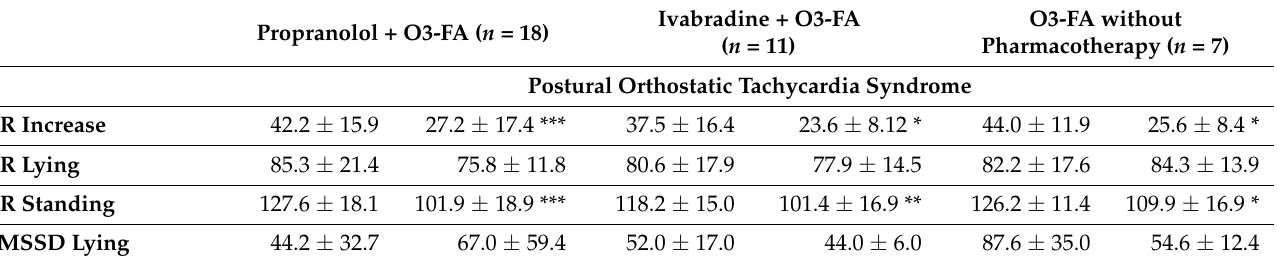
Table 2. The effect of the treatment on heart rate regulation in the active standing